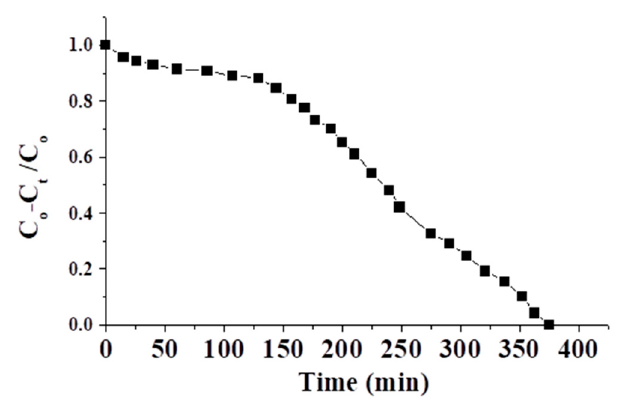
Figure 12. The breakthrough curve for brackish water of TDS = 10,000 ppm.